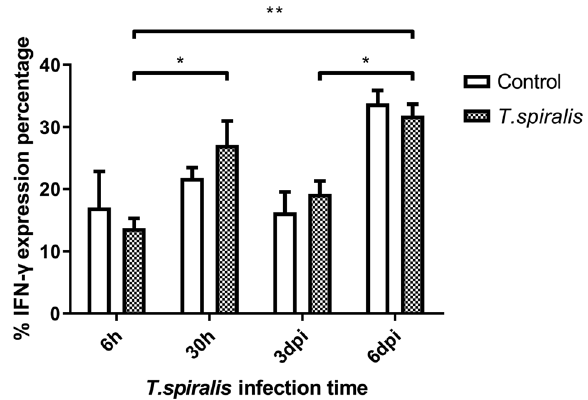
Figure 5. Percentage and expression of IL-17 of Th17 cells in mice infected with 250 muscle larvae of Trichinella spiralis compared to uninfected (control) mice from 6 h to 6 dpi. * p < 0.05 indicating a statistically signi fi cant